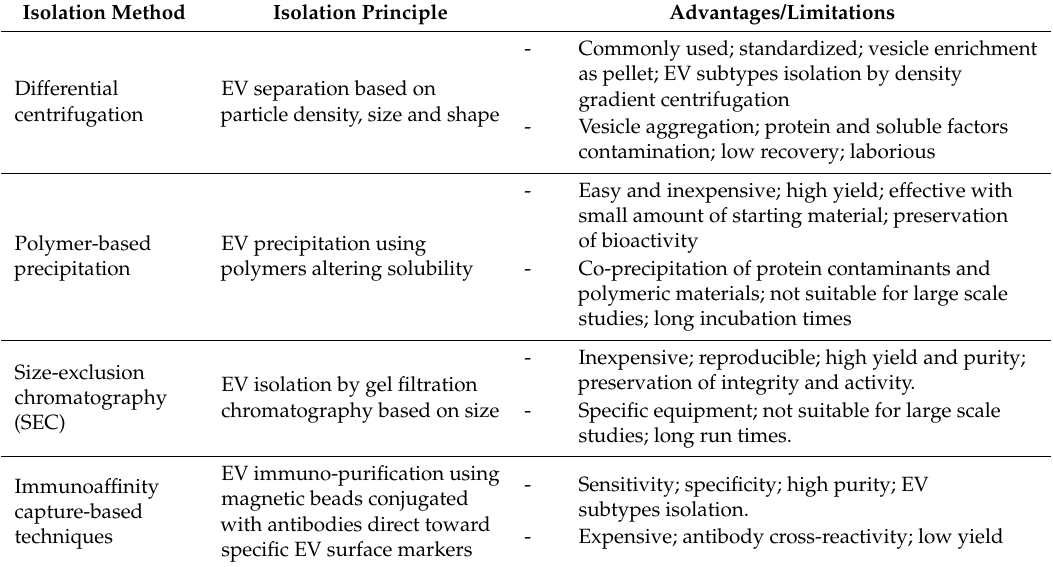
Table 1. Methods for Extracellular Vesicles (EV)